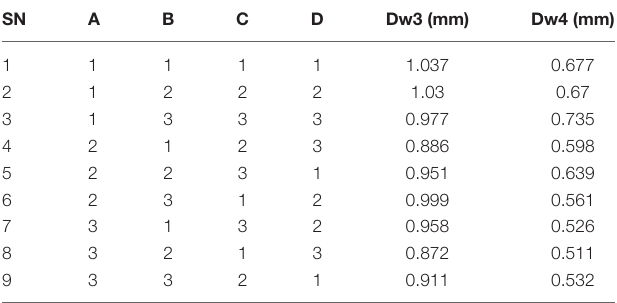
TABLE 3 | Table of orthogonal experimental.